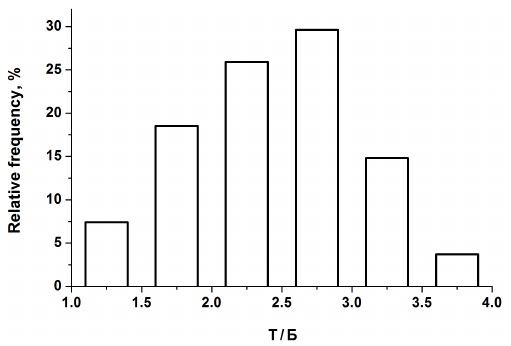
Figure 7. Frequency distribution of T / B ratio for the Russian cities along the Trans-Siberian Railway.